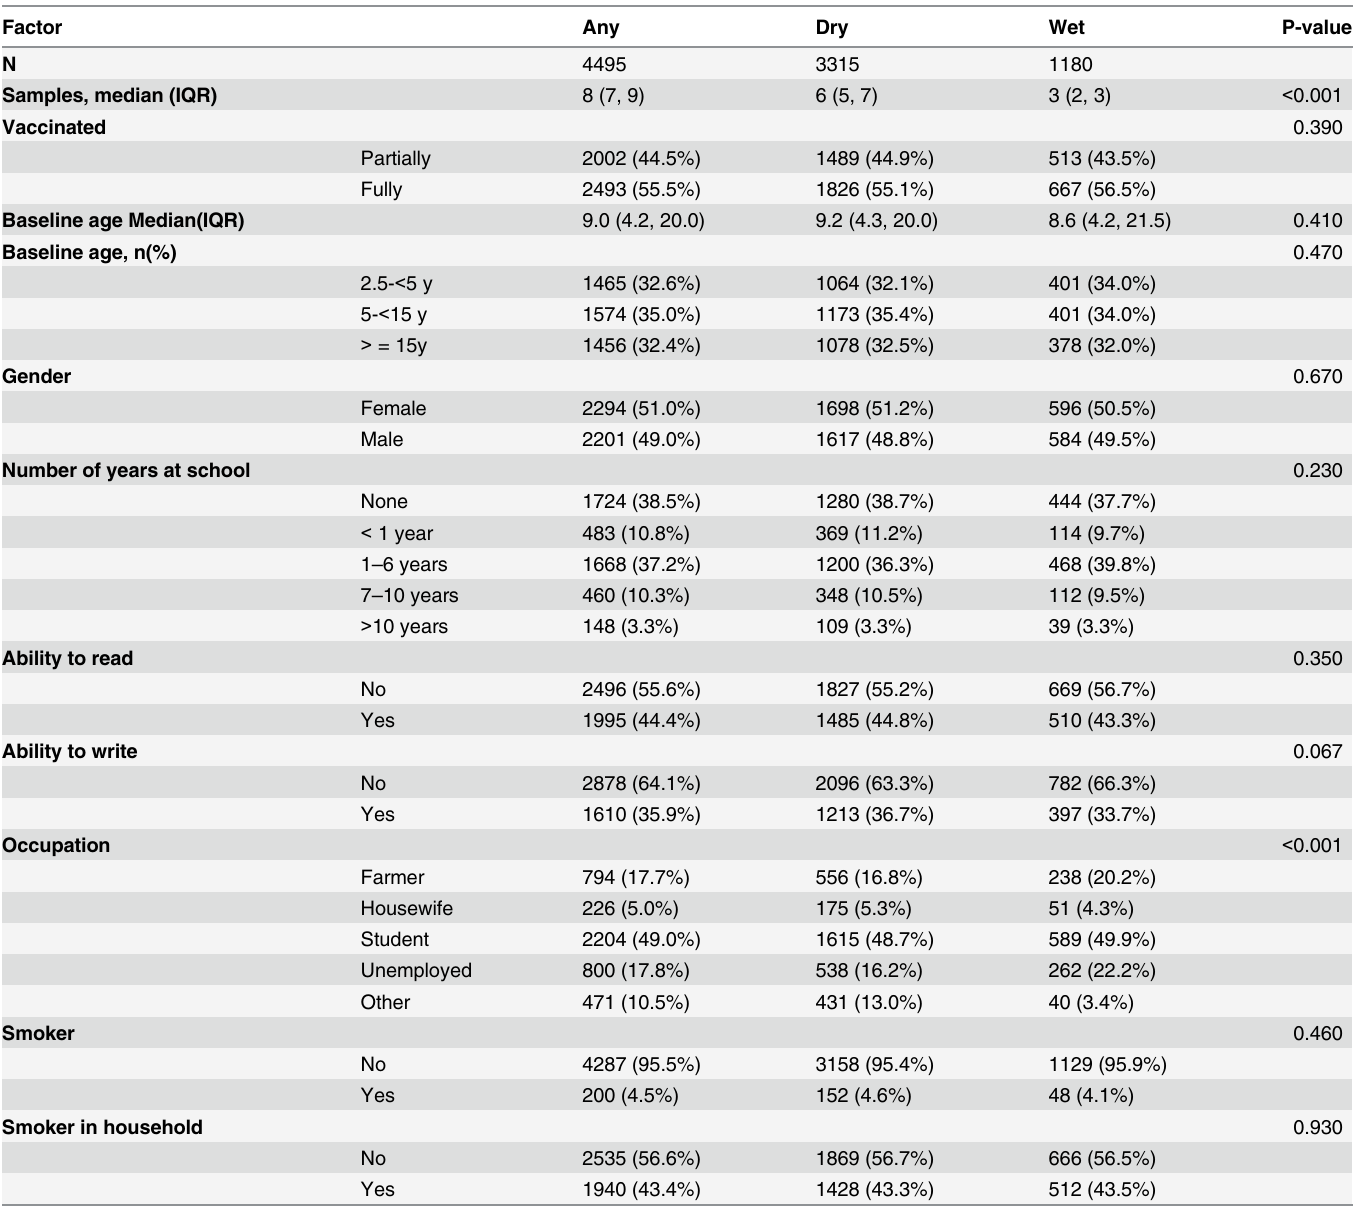
Table 2. Distribution of samples by